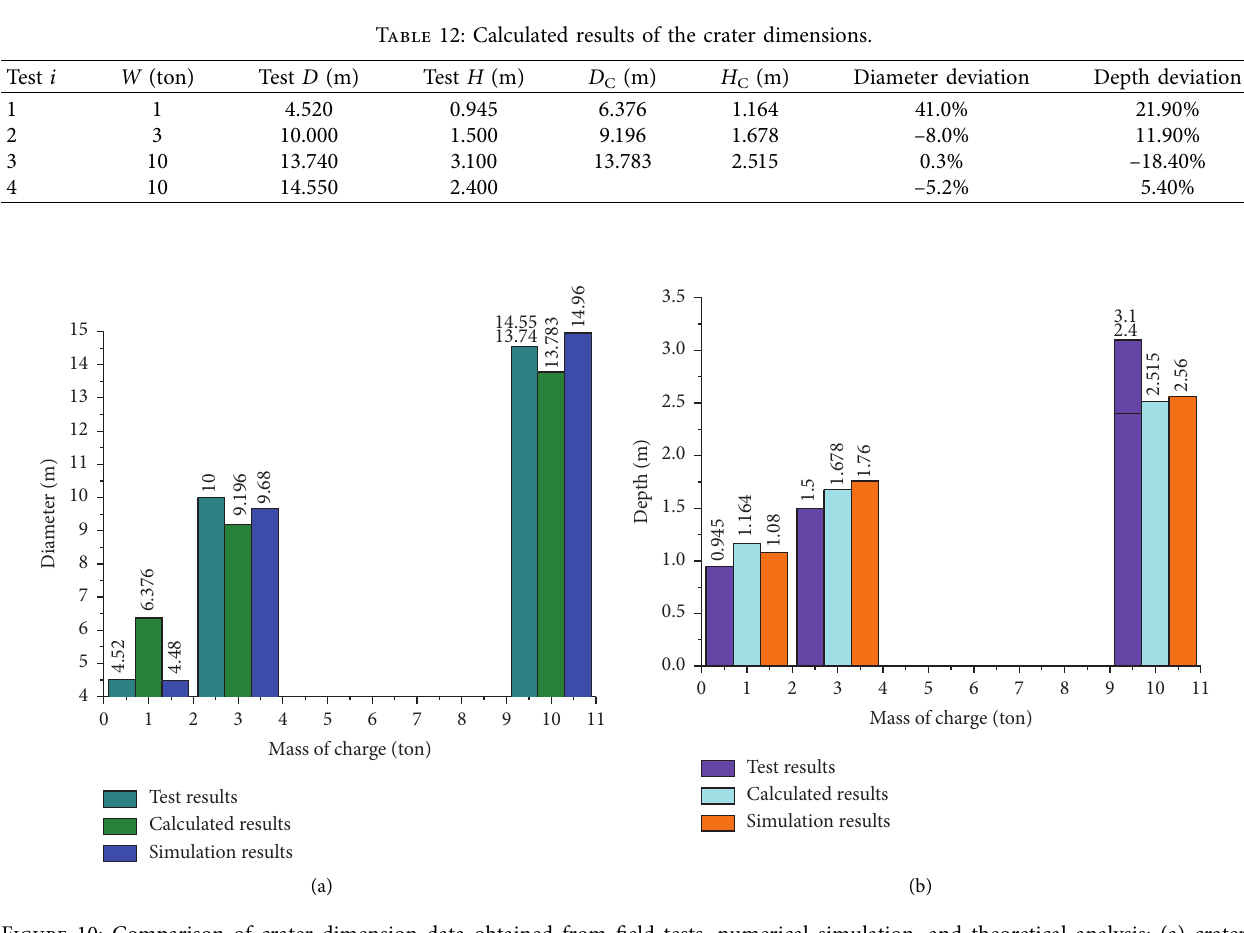
Figure 10: Comparison of crater dimension data obtained from field tests, numerical simulation, and theoretical analysis: (a) crater diameter and (b) crater